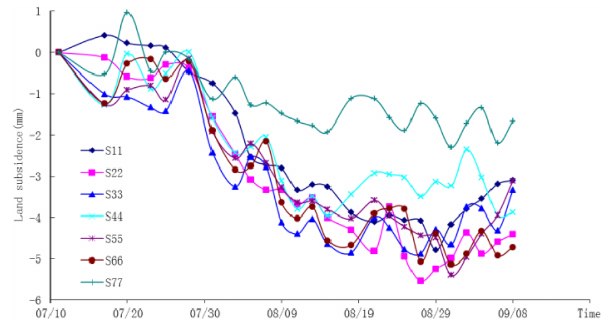
Figure 9. The observation data of deformation for individual layers and groundwater